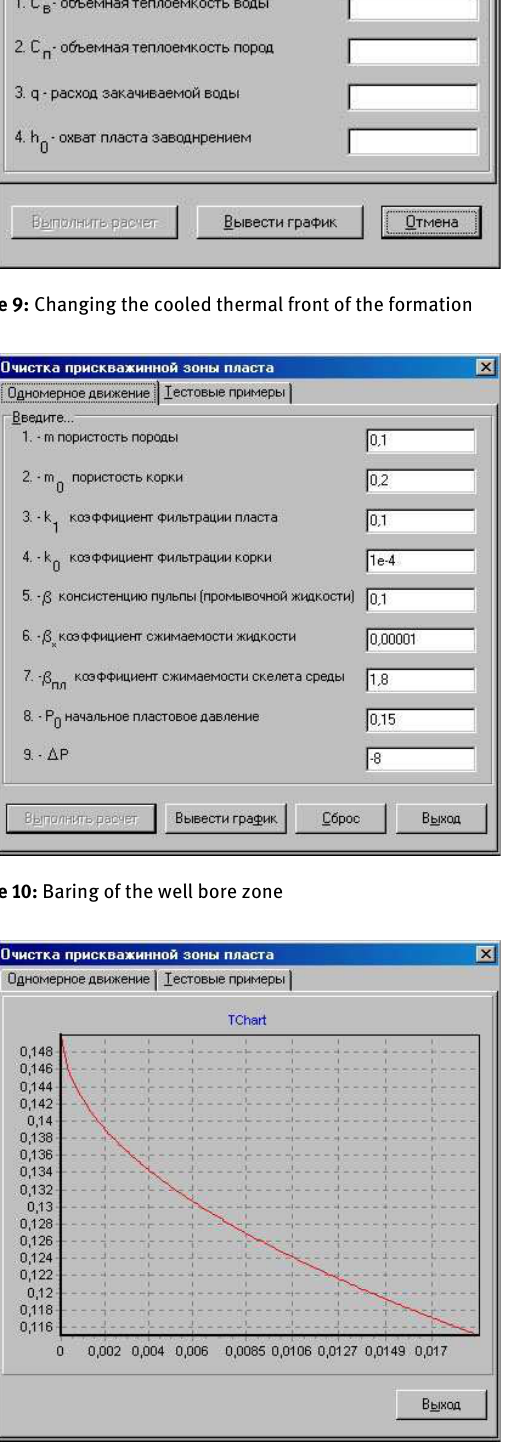
Figure 11: Reservoir response